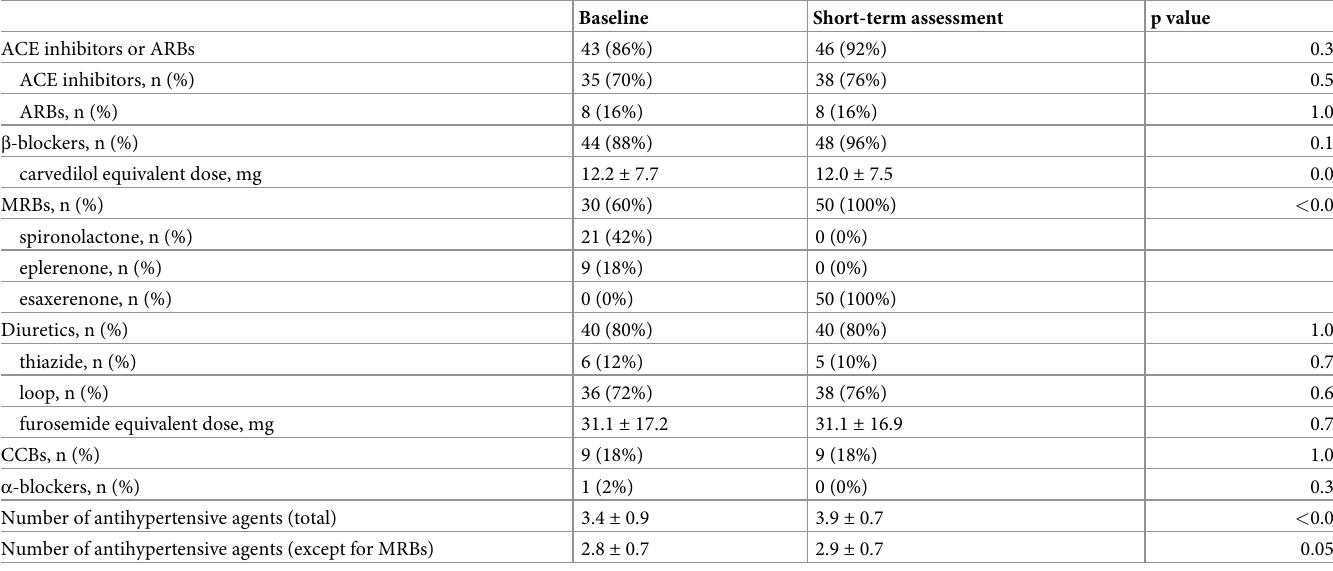
Table 2. Comparison of medication between baseline and the short-term assessment.